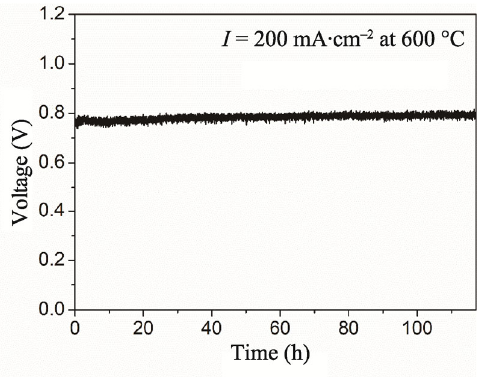
Fig. 8 Long-term stability of the FMCNC cell tested at 600 ℃